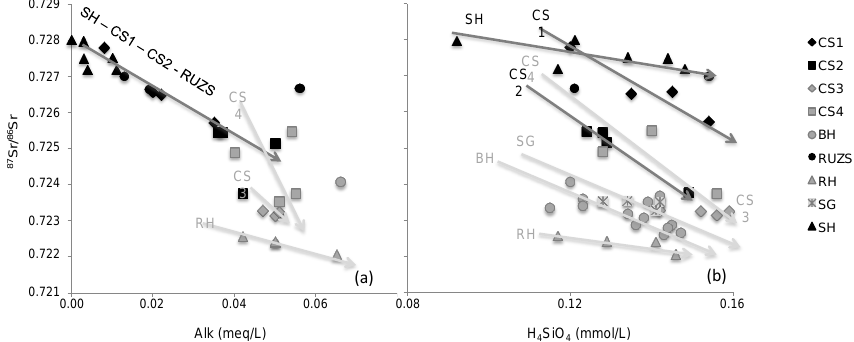
Figure 12. 87 Sr / 86 Sr vs. alkalinity (a) and Si concentrations (b) for the springs from the Strengbach watershed. For each of the individual spring the 87 Sr / 86 Sr ratios decrease with increasing alkalinity and Si content.